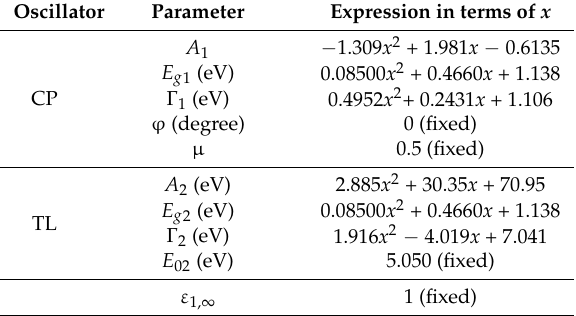
Table 3. Expressions given in terms of IGS composition x with x ≥ 0.56 for the critical point (CP) and Tauc-Lorentz (TL) oscillator parameters that define the ( ε 1 , ε 2 ) spectra. Among the ten possible variable parameters, four are fixed as shown and two are coupled in the fit. For the coupled parameters, the resonance energy of the very weak CP oscillator is equated to the Tauc gap of the TL oscillator which controls the absorption onset over this range of x . In fact, because of the low amplitude of the CP oscillator, its contribution to the spectra over this range is negligible. The polynomial expressions are appropriate for an IGS temperature of 400 ◦ C and a bulk layer thickness in the range of 3500–4100 Å. Oscillator